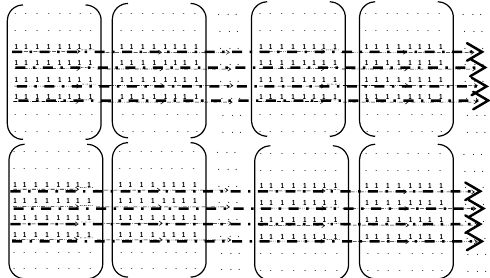
Figure 1. Location of mid band coefficients used for embedding.